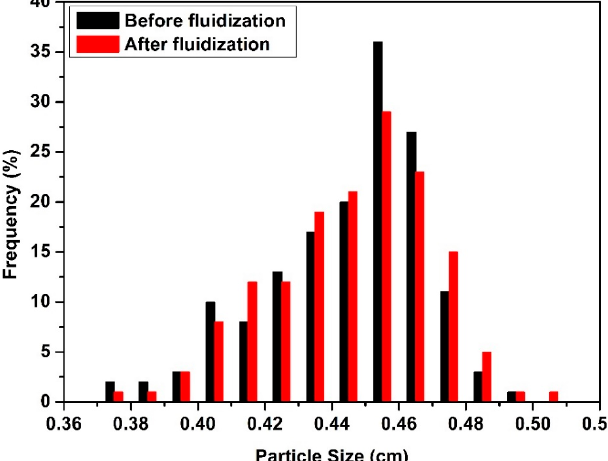
Figure 6. Particle size distribution of aerogel particles before and after Run #11.